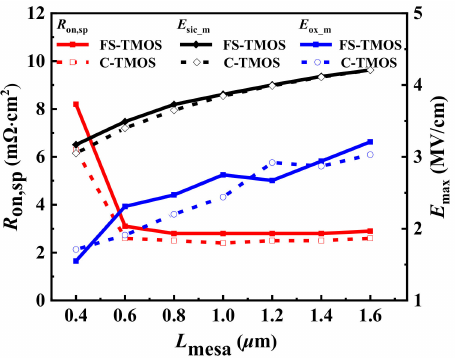
Figure 2. E ox_m and E sic_m (when the drain-source voltage V ds = 1200 V) and R on,sp dependent on L mesa .